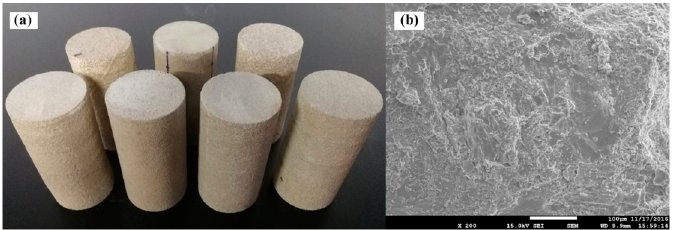
Figure 1. Sandstone specimens and fracture surface SEM. ( a ) Raw rock samples; ( b ) SEM of specimen at 200x magnification.